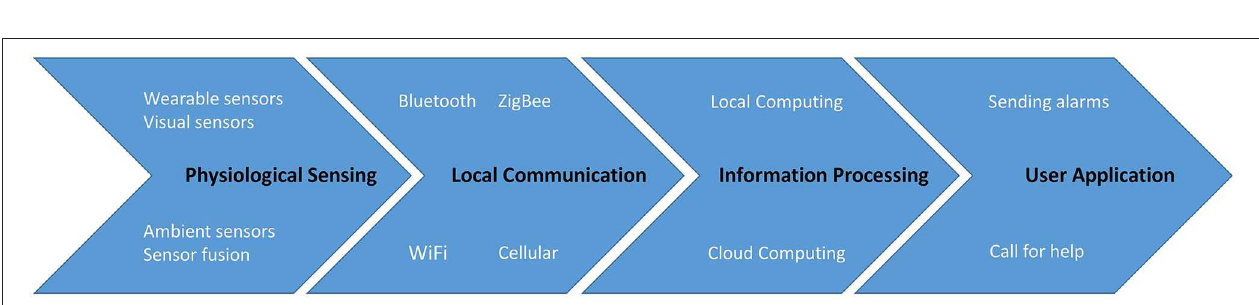
FIGURE 4 | The main components typically present within fall detection system architectures include the illustrated sequence of four layers. Data is collected in the physiological sensing layer, transferred through the local communication layer, then it is analyzed in the information processing layer, and finally the results are presented in the user application